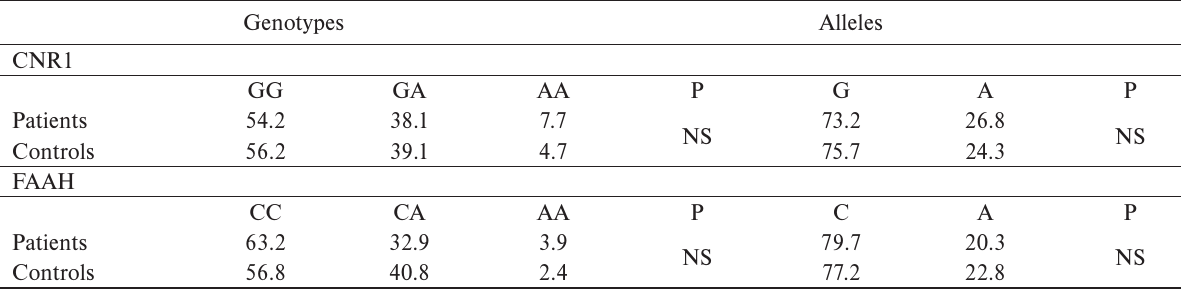
Table 2. Genotype and allele frequencies of CNR1 and FAAH.